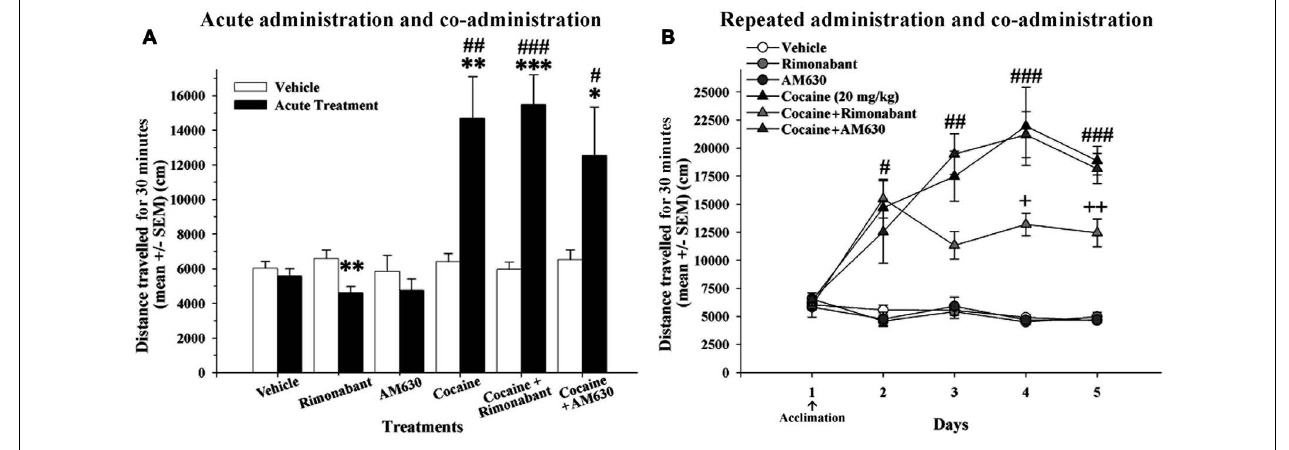
FIGURE 2 | (A) Effects of acute administration of cocaine and co-administration of cocaine (20 mg/kg) and Rimonabant (3 mg/kg) or AM630 (3 mg/kg) in the OF test. The acute cocaine-treated groups (cocaine, cocaine + Rimonabant and cocaine + AM630) exhibited significant increases in locomotor activity compared to the previous vehicle administration on day 1 ( ∗ P < 0.05, ∗∗ P < 0.01, ∗∗∗ P < 0.001) and compared to the vehicle group ( # P < 0.05, ## P < 0.01, ### P < 0.001). (B) The effects of repeated administration of cocaine and co-administration of cocaine (20 mg/kg) and Rimonabant (3 mg/kg)